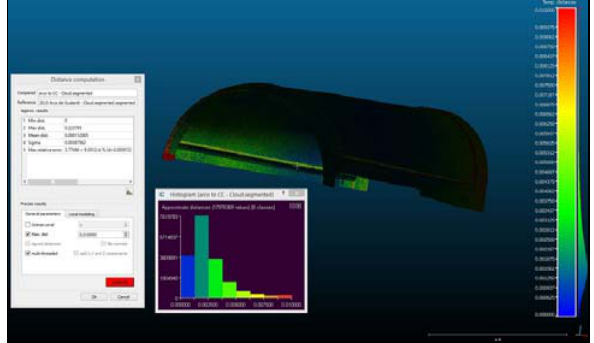
Figure 21 – Comparison of both point clouds (PhPC and ScPC) to maximum distance = 10 mm and Histogram with 8 range columns of distance diferences.